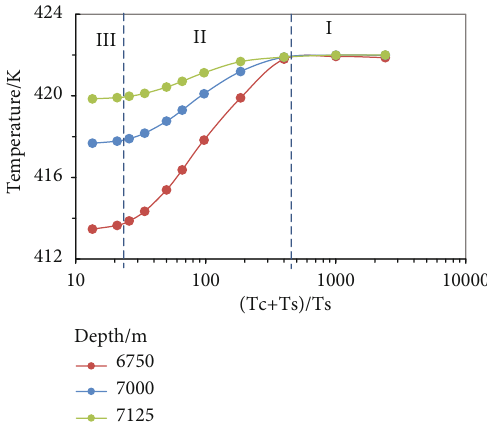
Figure 9: Temperature recovery curve after shut-in.